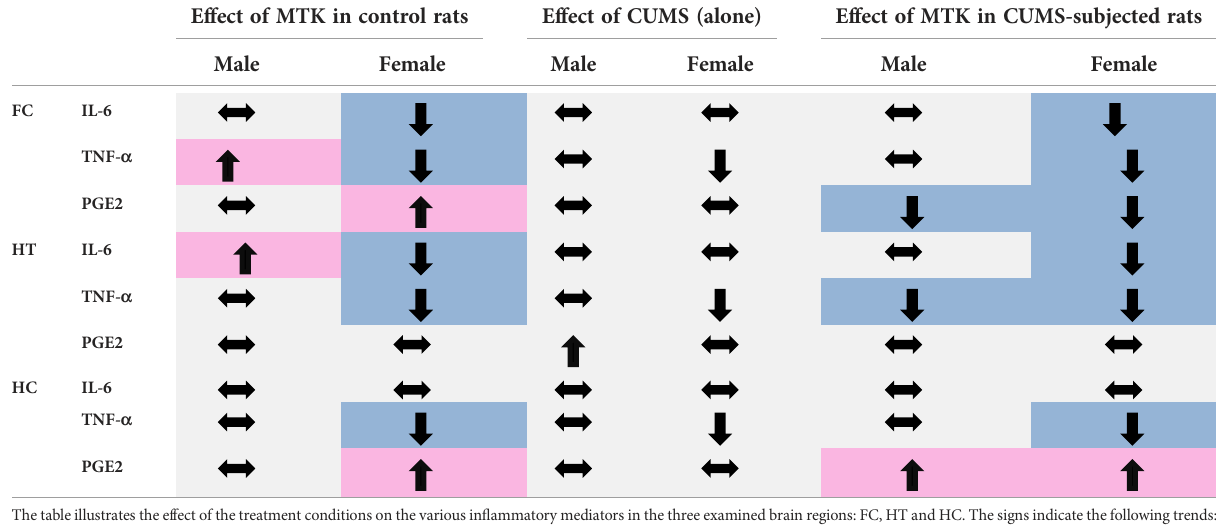
- a decrease; pink - a pro-in fl ammatory effectof MTK; blue - an anti-in fl ammatory effectof MTK. CUMS, chronicunpredictable mild stress; FC, frontal cortex; HC, hippocampus; HT, hypothalamus; IL-6, interleukin-6; MTK, montelukast; PGE2, prostaglandin E2; TNF- a , tumor necrosis factor- a